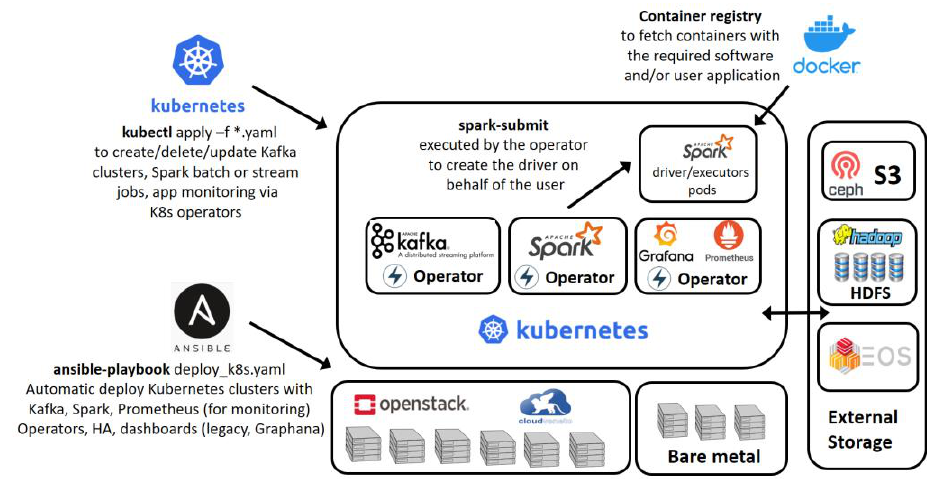
Fig. 1. Automatic deployment and execution of workloads on the Big Data Analytics platform based on Ansible, Kubernetes and Docker